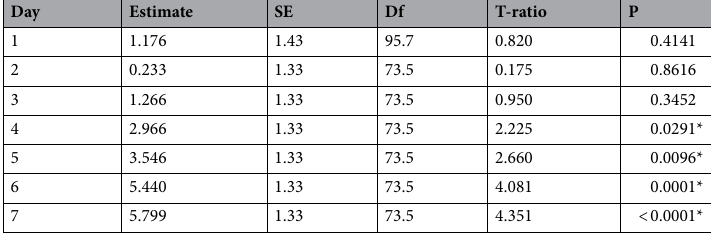
Table 3. Estimated marginal means, comparing nest depth under cool and warm temperature treatments. Nest depth began to significantly differ between temperature treatments on Day 4. Results are averaged over natal elevation. *Significant, ⍺ =